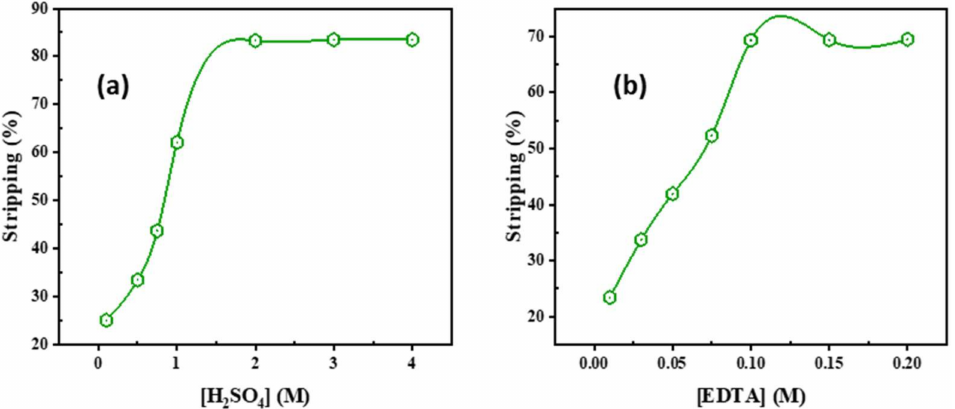
Figure 3. Influence of ( a ) H 2 SO 4 ; ( b ) EDTA concentration upon Cd 2+ stripping from the loaded Adogen